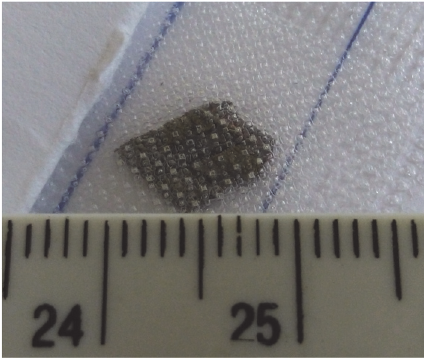
Figure 2: Large stone